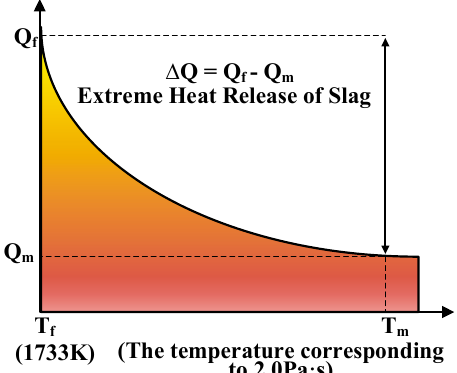
Figure 1. XRD curves of the quenched samples.